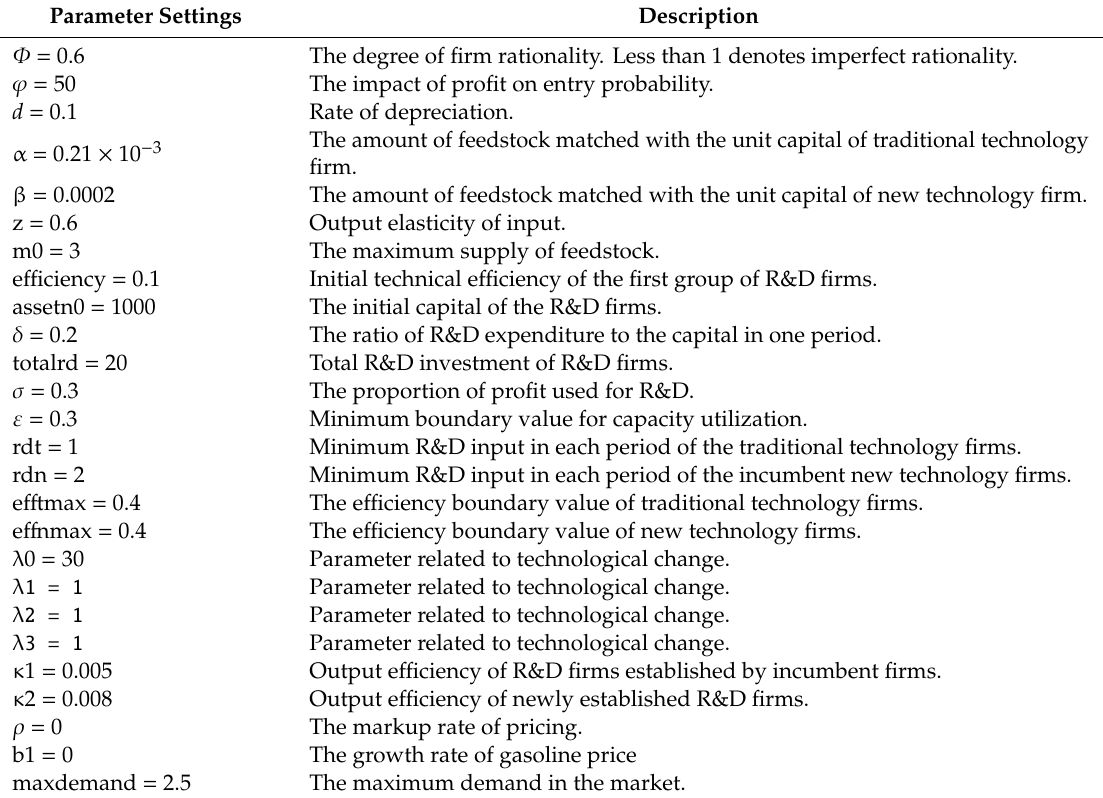
Table A2. The setting of the parameters’ values of the fuel ethanol industry (baseline